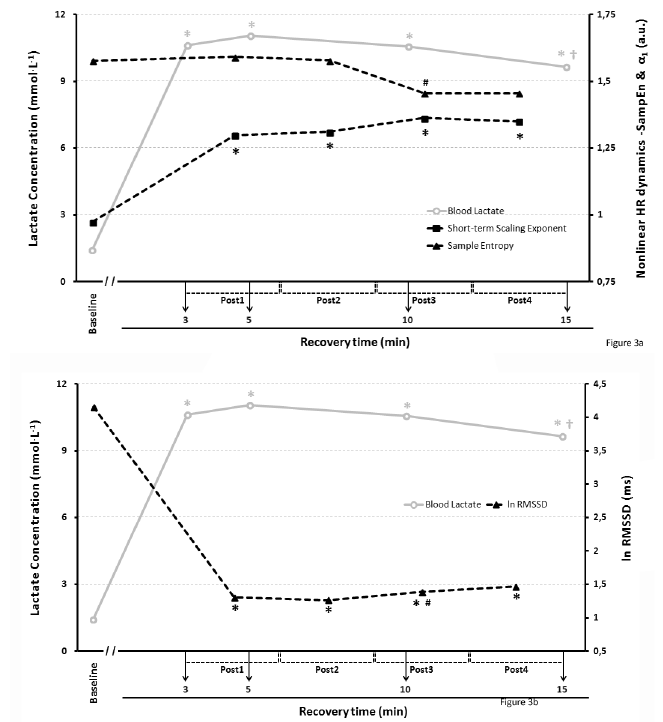
Figure 3. Heart Rate and lactate dynamics through the recovery period following BSJT. Nonlinear (Figure 3a) and Linear (Figure 3b) indices in black lines; lactate in a grey line. Under figure : * Significantly different from baseline condition (p<0.05 for α1; p<0.001 for lnRMSSD; p<0.01 for lactate); † Significantly different from [La]5. # Figure 3a: trend to significant difference from Post2 condition (p=0,056); # Figure 3b: Significantly different from Post2 condition (p<0.05). doi: